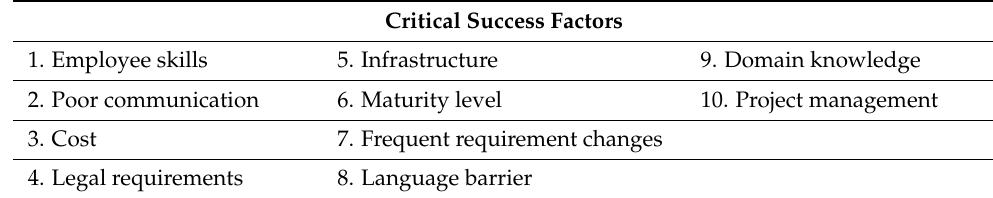
Table 2. Factors ranked as critical success factors.